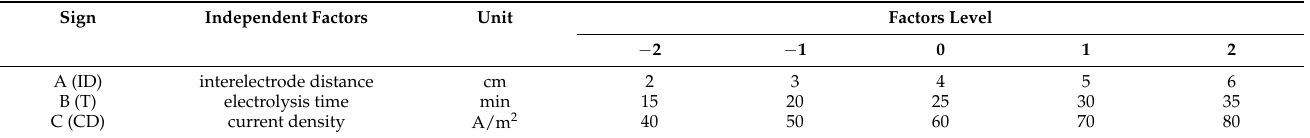
Table 3. The coded independent factors and levels of the independent factors used for